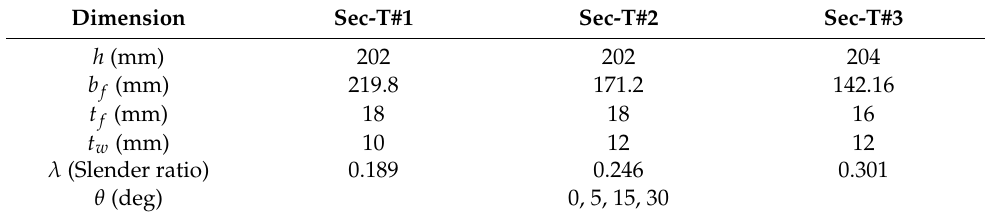
Table 4. Dimension of Sections and